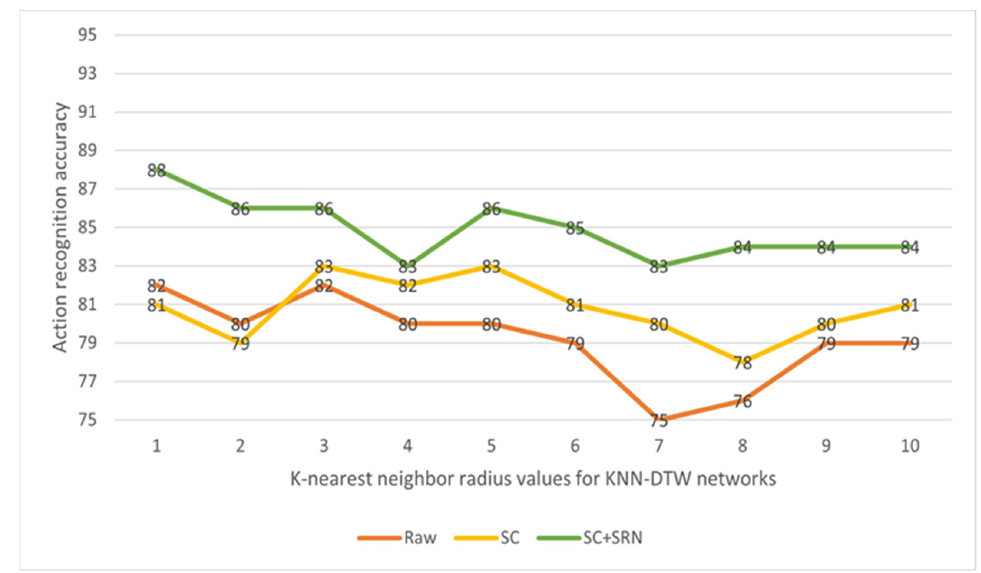
Figure 4. Classification results for KTH-5 with different radius K parameters using KNN-DTW network (the results are retained as integers).